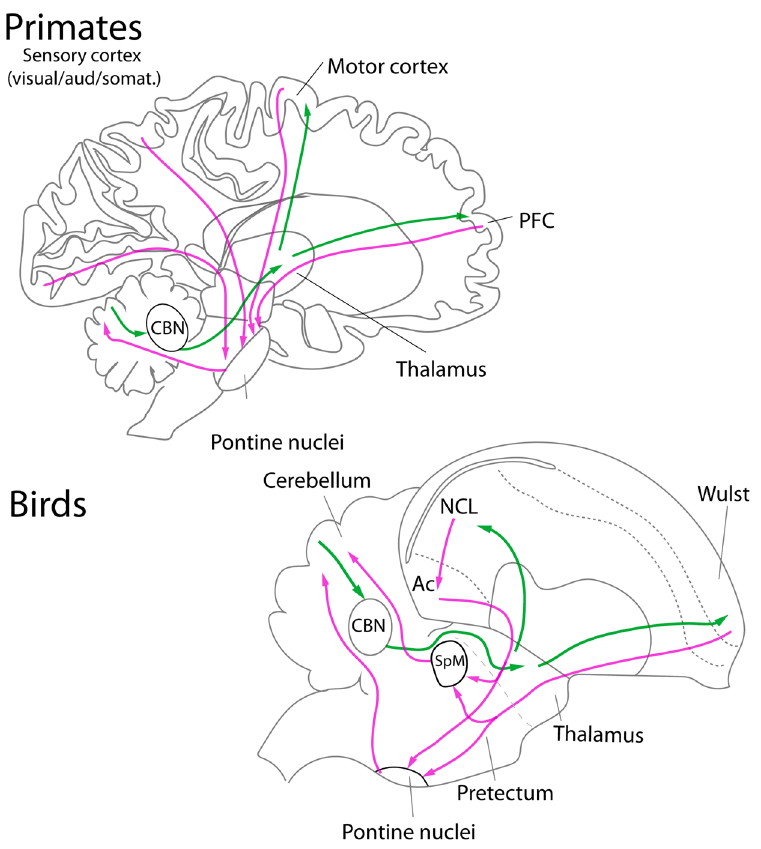
Figure 1. Cortico-cerebellar pathways in birds and mammals. In mammals, inputs from the cortex to the cerebellum are routed through the pontine nuclei. In birds, inputs from the telencephalon to the cerebellum are also routed through two nuclei in the base of the pons (medial and lateral pontine nuclei, PM and PL) but also trough an additional nucleus in the pretectum, the medial spiriform nuclei (SpM). In mammals the cerebellum, through the cerebellar nuclei (CBN) sends projections back to the thalamus, which in turn projects to motor and associative areas of the cortex. In birds there also a projection from the cerebellum to the thalamus but this arises from the lateral cerebellar nucleus. In turn, these regions of the thalamus projects the nidopallium caudolaterale (NCL), (the avian analogous of the prefrontal cortex of mammals), and the rostral Wulst, (the avian equivalent of motor